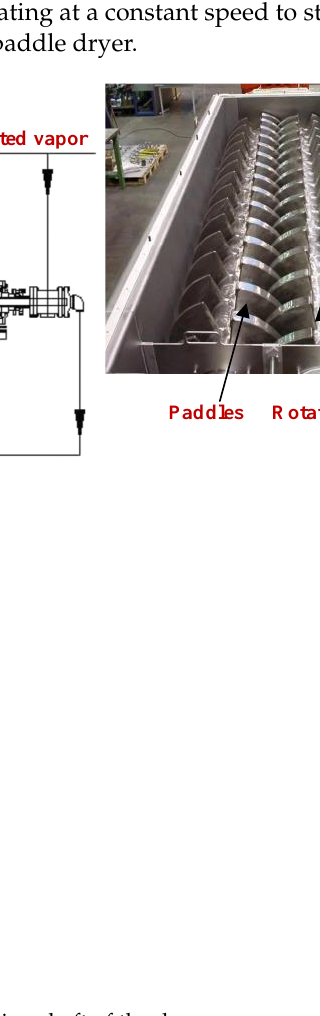
Figure 2. Schematic of the paddles and the rotating shaft of the dryer.